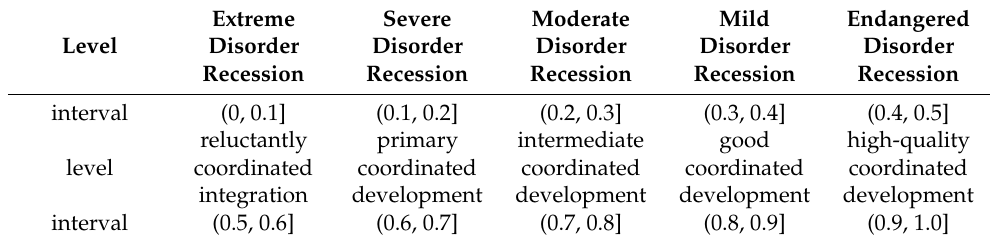
Table 3. Coupling coordination degree